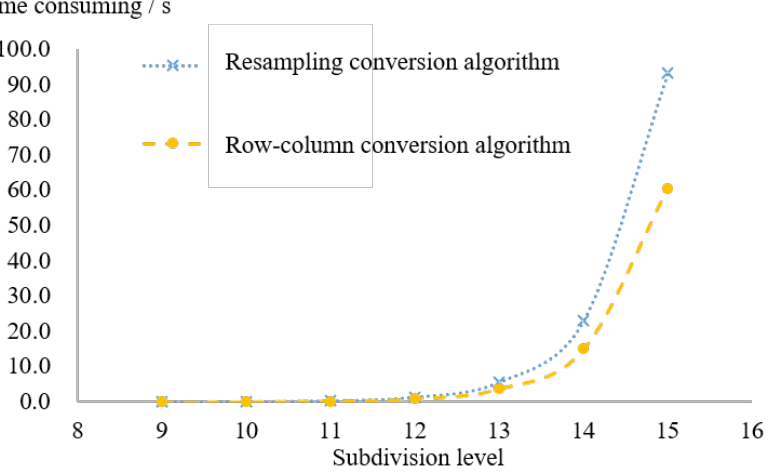
Figure 25. The time-consumption of the algorithms of conversion from Goodchild encoding to TRQ encoding.